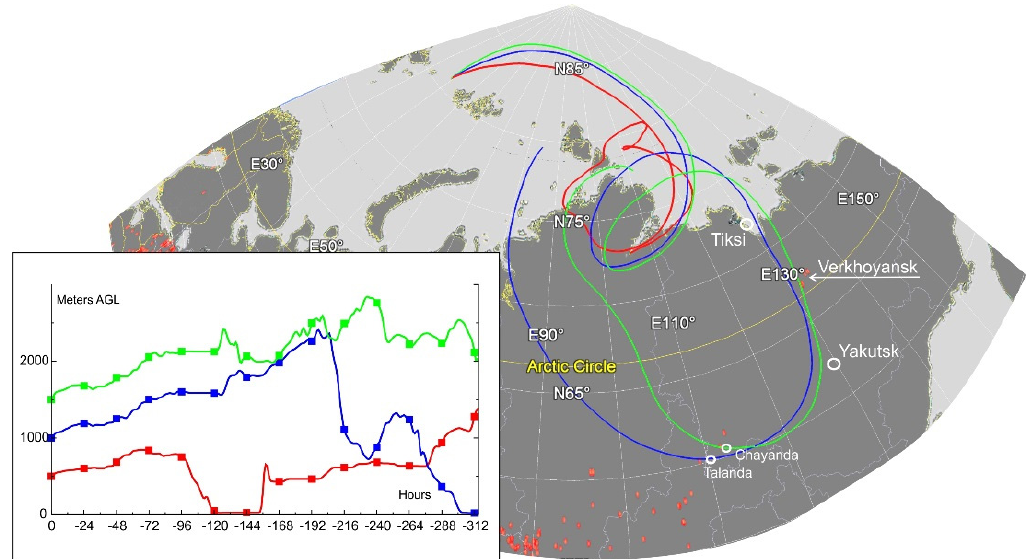
Figure 6. Back trajectories and heights above ground level (AGL) of air mass motion to the region of drift of RV Akademik Tryoshnikov in ice on 22 April 2019.